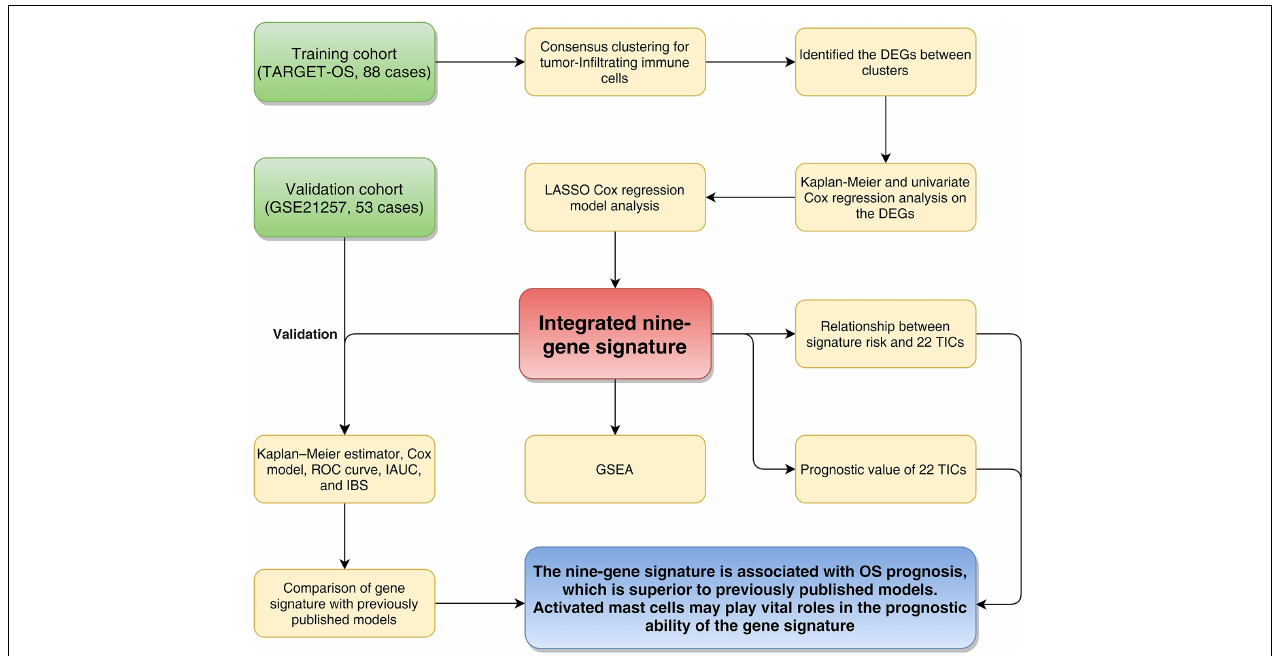
FIGURE 1 | Flowchart of the study. TARGET: therapeutically applicable research to generate effective treatments; OS, osteosarcoma; DEGs, differentially expressed genes; LASSO, least absolute shrinkage and selection operator Cox regression model; AUC, area under the ROC curve; IAUC, integrated AUC; ROC, receiver operating characteristic; IBS, integrated Brier score; GSEA, Gene Set Enrichment Analysis; TICs, tumor-infiltrating immune